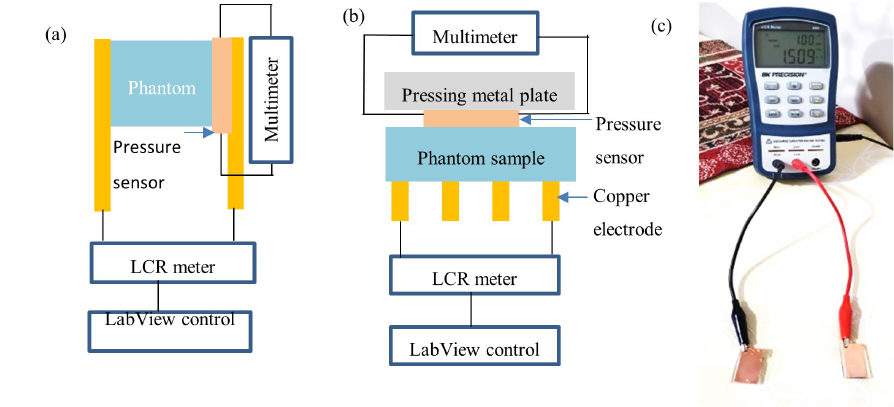
Figure 2. (a) Parallel plate configuration, (b) interdigital electrode configuration, (c) metal pads with LCR meter